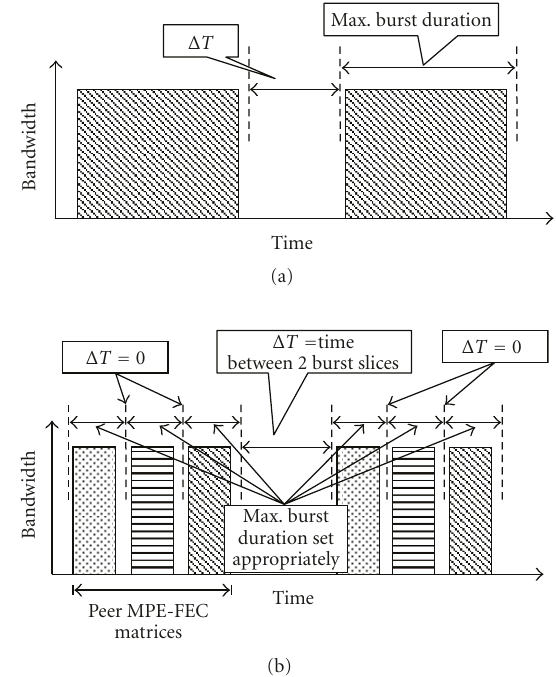
Figure 5: MPE-FEC matrix construction and transmission: (a) without UEP and (b) with